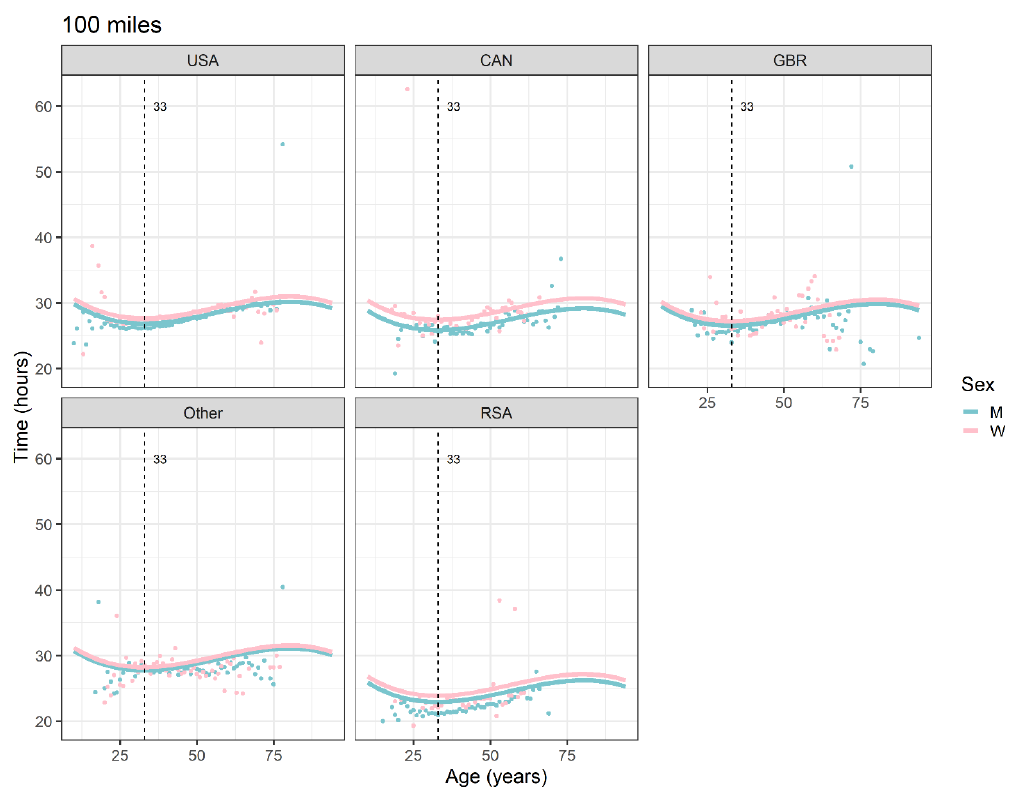
Figure 2. Ultra-marathon speed, 100 miles, by sex, age (in years), and country. Points are race-time averages. Lines are fitted curves (mixed model). Vertical lines with numeric labels are the ages at peak performance. The sample sizes decrease towards the minimum and maximum of the age axes, with some of the points reflecting only individuals; for example, the five points corresponding with GBR men 75+ years of age reflect one individual each, one of the three remarkable individuals (Geoffrey Oliver) accounting for three of the five points [36]. USA = United States of America, CAN = Canada, GBR = Great Britain, RSA = Republic of South Africa, W = women, M = men.